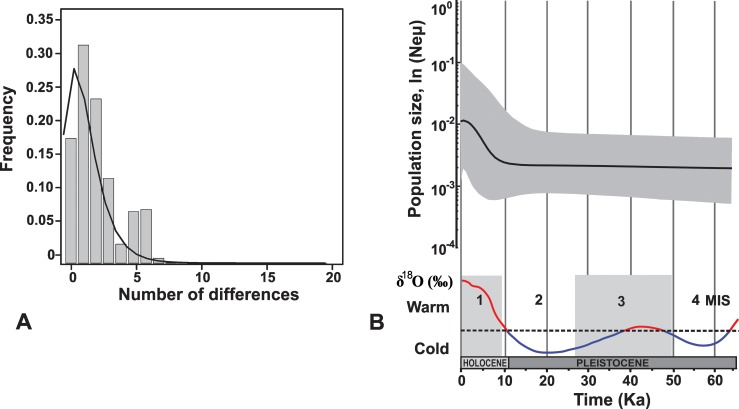
A—Mismatch distribution for R. nasutus based on cyt b sequences. Bars represent observed values, lines represent expected values under the model of sudden population growth; B—Calibrated demographic history of R. nasutus and reconstructed paleoclimatic history. Shaded areas correspond to 1st and 3rd Marine Isotope Stages.